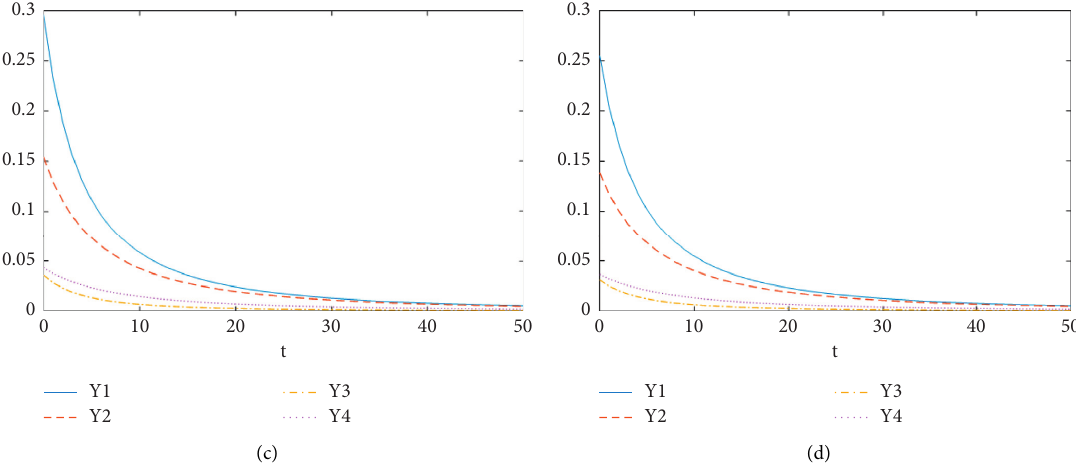
Figure 2: Optimal carbon emissions under different parameter values ( s